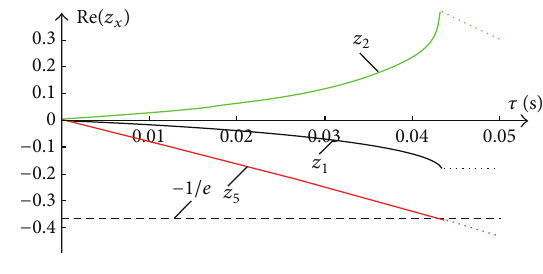
Figure 15: Curves of 𝜏 - 𝑧 1 , 𝜏 - 𝑧 2 , and 𝜏 - 𝑧 5